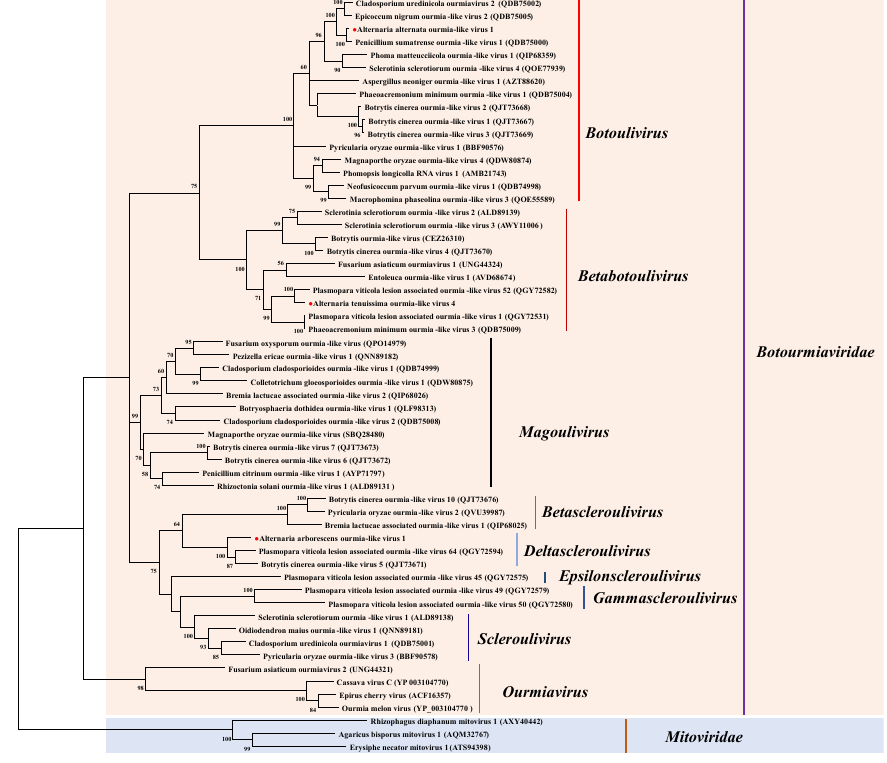
Figure 2. Phylogenetic analysis of AarOLV1, AalOLV1, AtOLV4. The novel viruses obtained by high throughput sequencing were indicated by a red circle ( ● ). The data coverage percentages were shown by the numbers on the left of branches. We constructed a phylogenetic tree using the maximum likelihood method. We based the 1000 bootstrap replications on the best-fit protein evolution (LG+G+I+F) model. We set the gamma value at